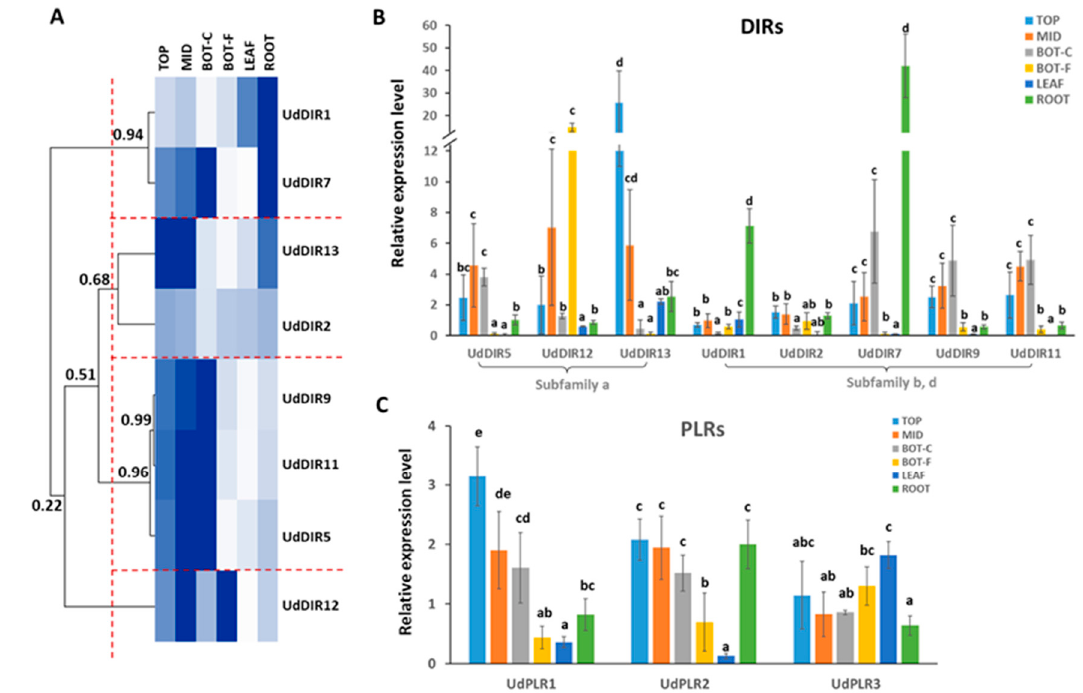
Figure 6. ( A ) Hierarchical clustering of UdDIR s expression profiles in different organs and tissues. The correlation coefficient of each cluster is indicated on the branch. Four expression patterns are obtained using Pearson coefficient 0.68 as the threshold and are indicated with red dashed lines. Relative expression of DIR s ( B ) and PLR s ( C ) in different tissues. TOP, top internode; MID, middle internode; BOT-C, core tissue of bottom internode; BOT-F, cortical tissue of bottom internode. Standard deviation was calculated from the values of four biological replicates. A one-way ANOVA with Tukey’s post-hoc test was used to determine statistically significant differences among the groups, which are indicated with different letters.